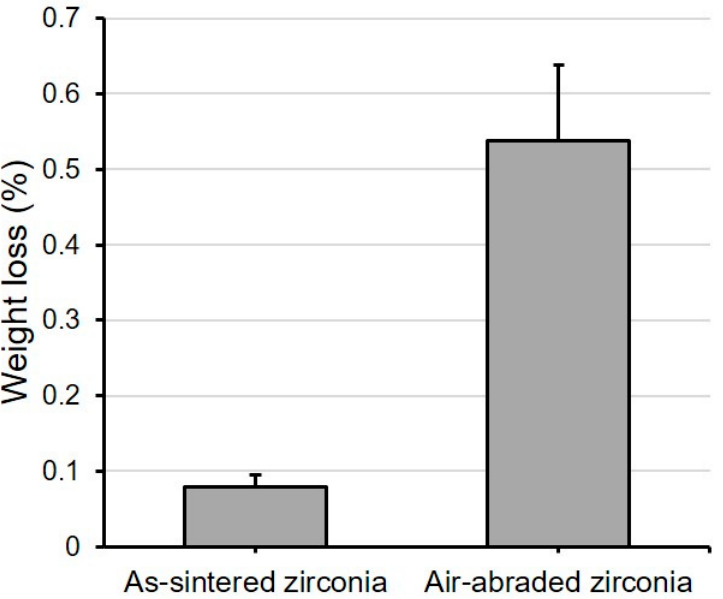
Figure 5. The weights of as-sintered zirconia and air-abraded zirconia were evaluated before and after the etching process. In the air-abraded zirconia group, the weight after etching decreased significantly about 0.54% compared to the 0.08% loss in the as-sintered group ( p < 0.001).